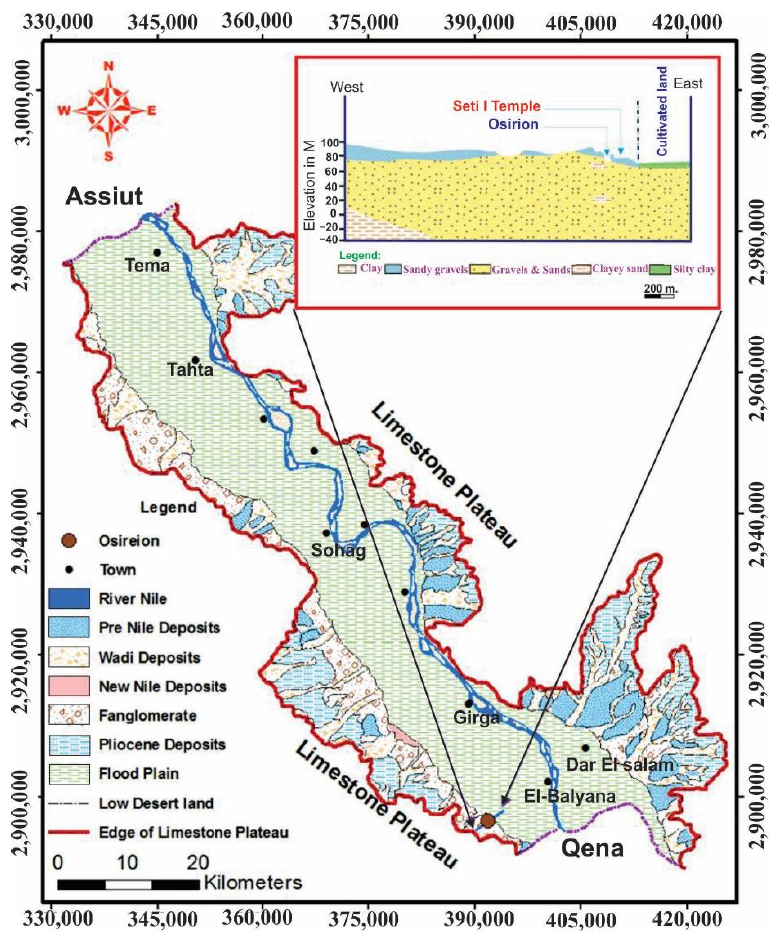
Figure 3. Geological map of Sohag governorate, including the study area that shows the main surface geologic units [32] and cross section through the study area passing through the Osirion site (modified after [20]).